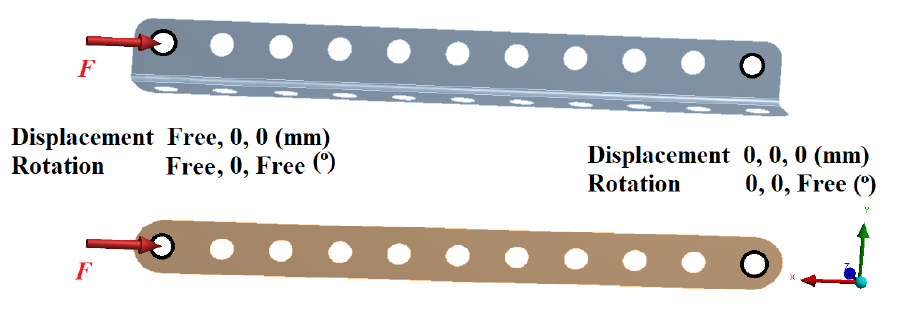
Figure 10. Boundary conditions for estimating critical forces for I and L